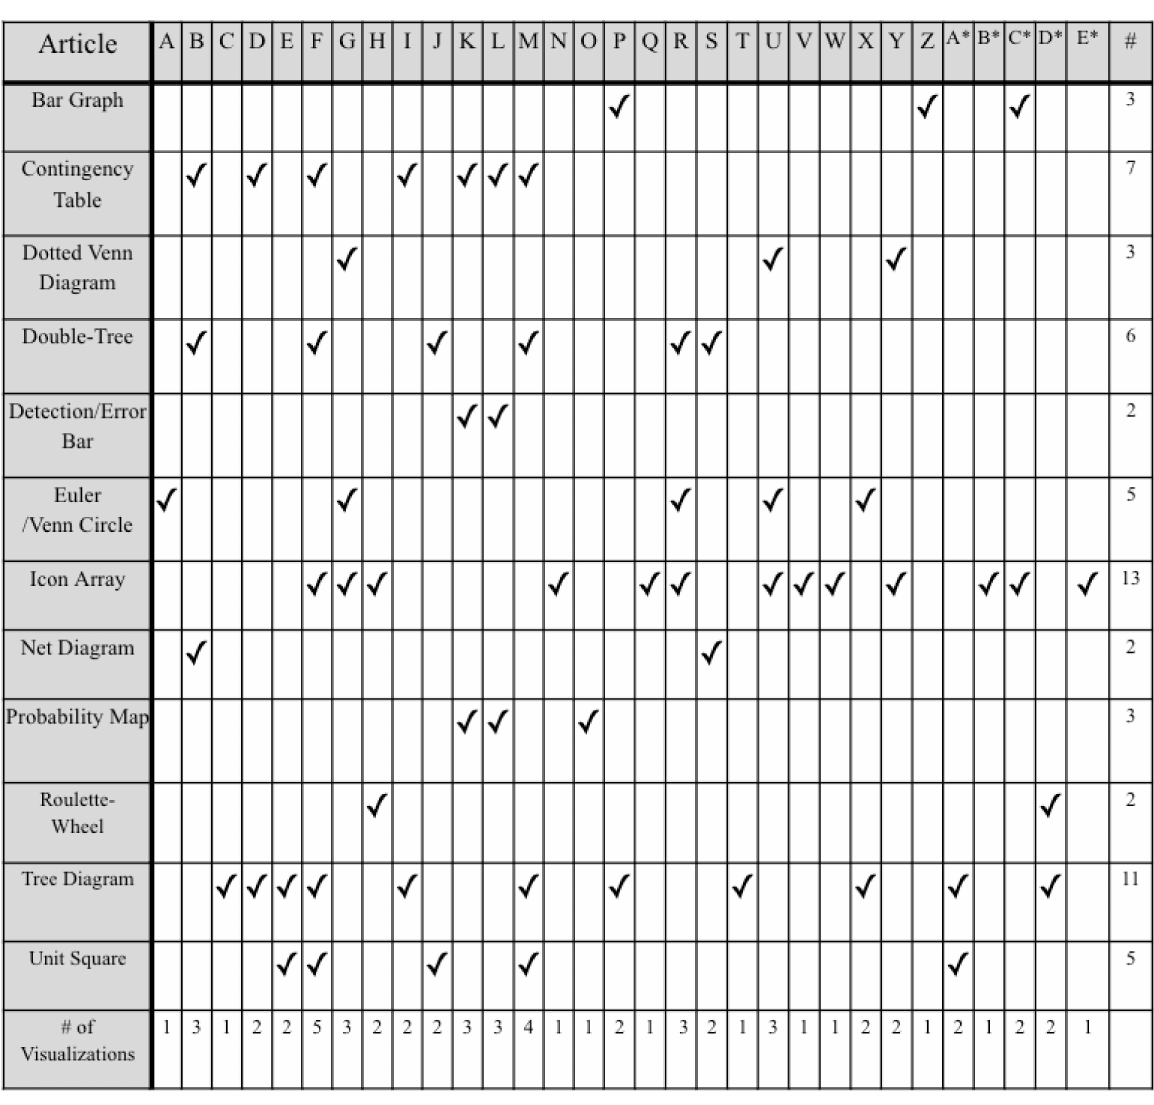
Figure 1. Types of visualizations used in articles. See Table 1 for key for article